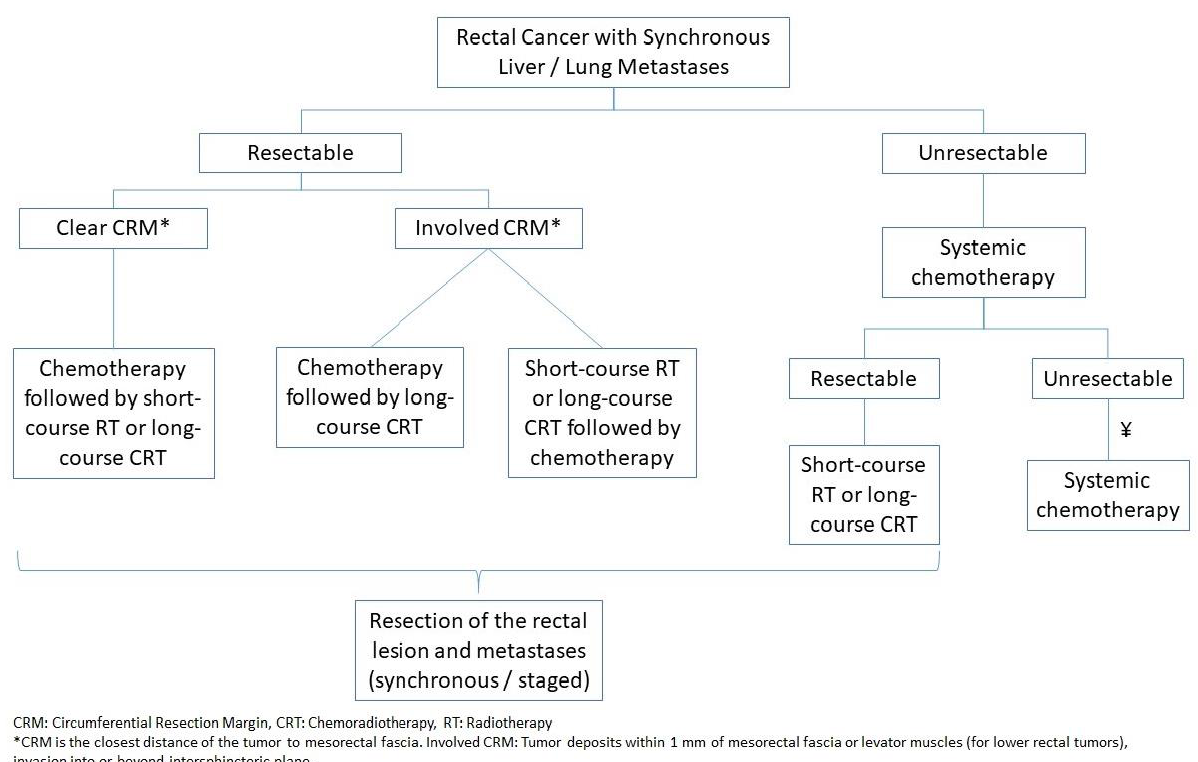
Figure 2. Treatment Algorithm for Stage IV Rectal Cancer with Synchronous Liver/Lung Metastases.